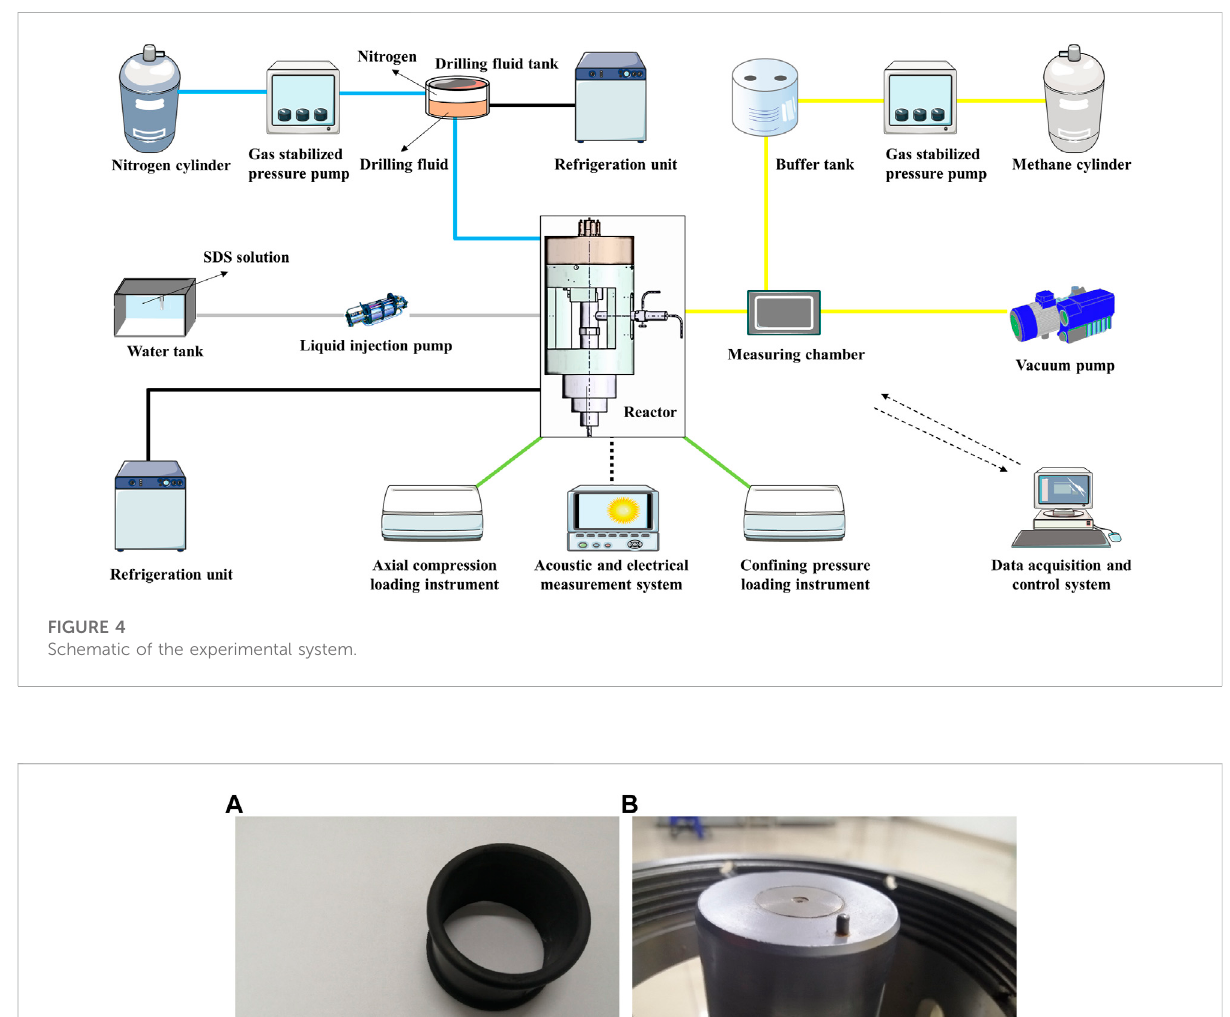
FIGURE 5 Therubbercylinder (A) andlowersteelshaft (B) ofgashydratereactor.Thediameteroftherubbercylinderis60 mm,andthesizeoftheinternal space of the reactor can be reduced with the compression of the lower steel